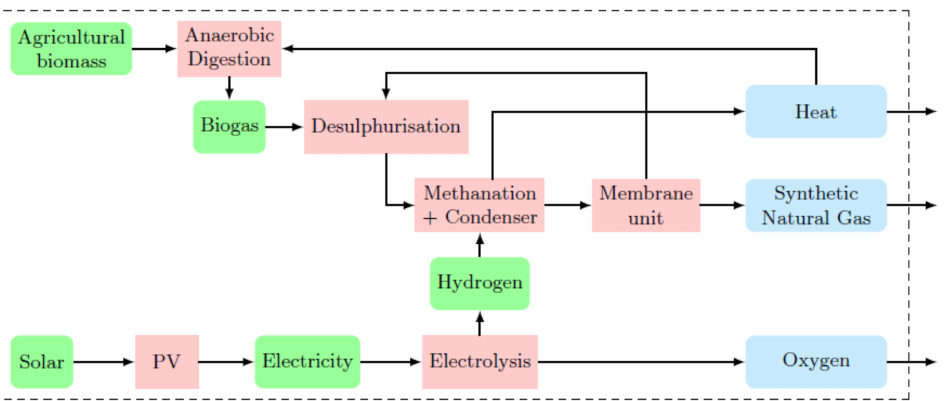
Figure 6. Power to X process flowchart using biogas as CO 2 source to produce synthetic natural gas. Resources and intermediate energy carriers are depicted as green, processes red and final products and energy carriers